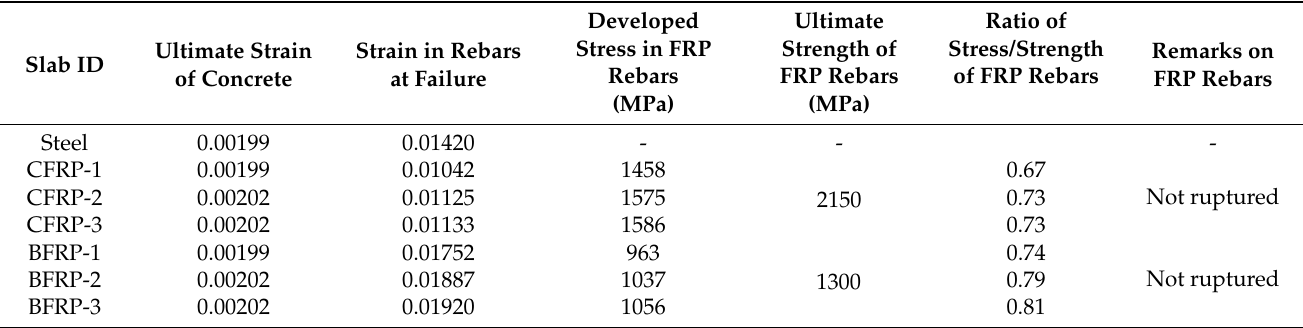
Figure 10. Strain distribution in the reinforcements of the slabs tested. Table 7. Stress and strain values of the FRP rebars in the slabs at failure load.